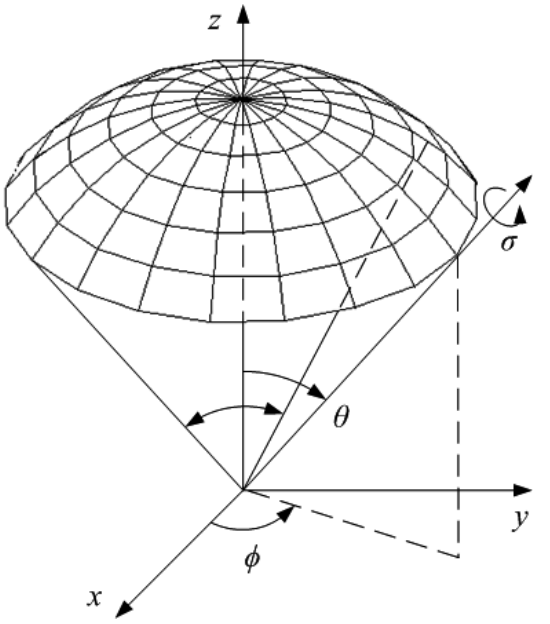
Figure 4: The representation of the regular workspace for the SPM with a pointing